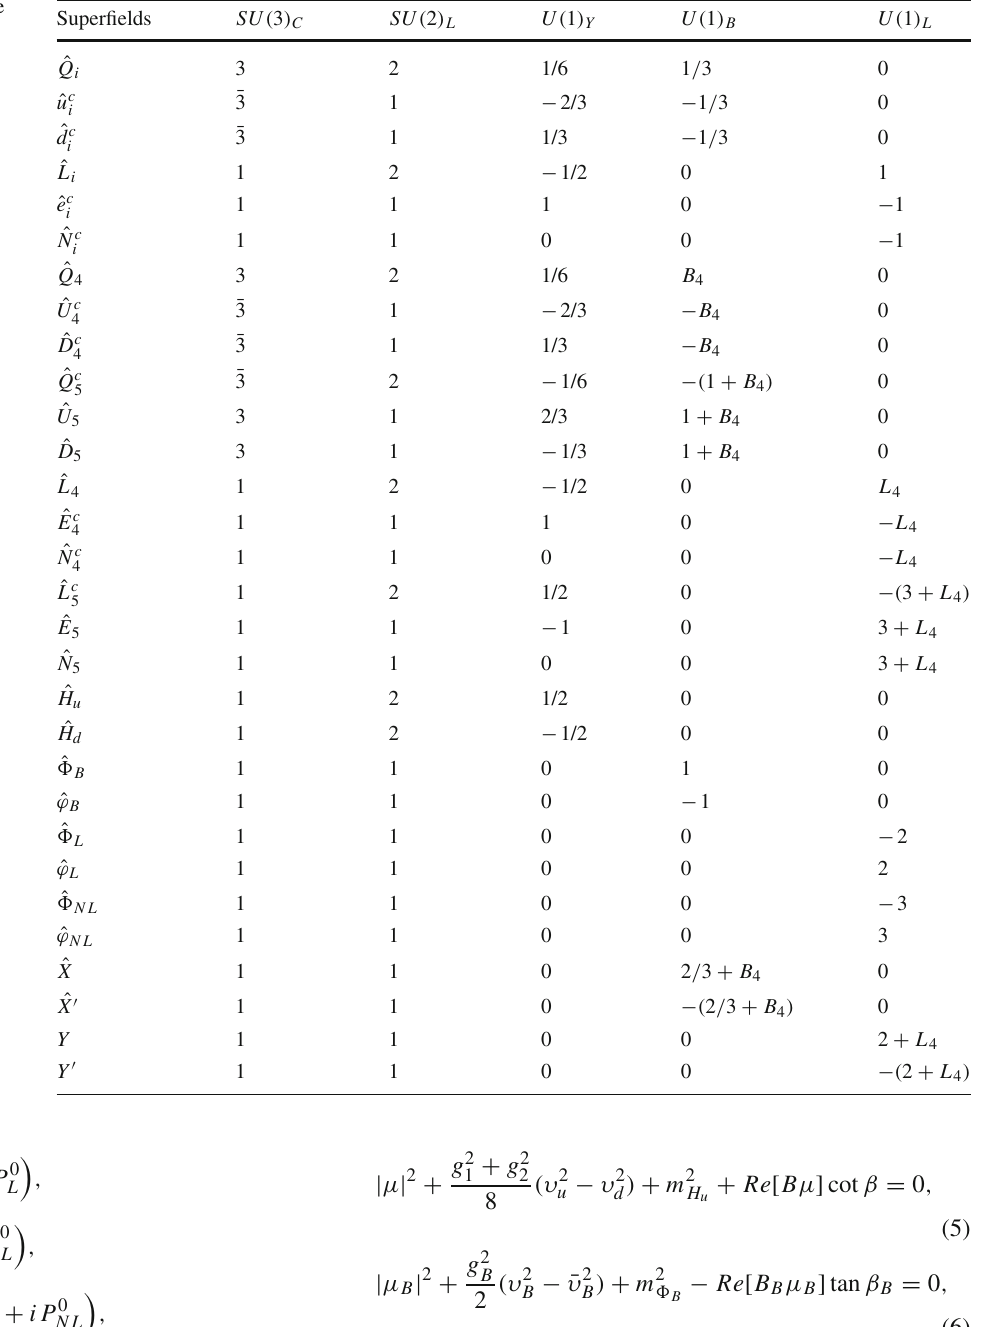
Table 1 The super fields in the extended